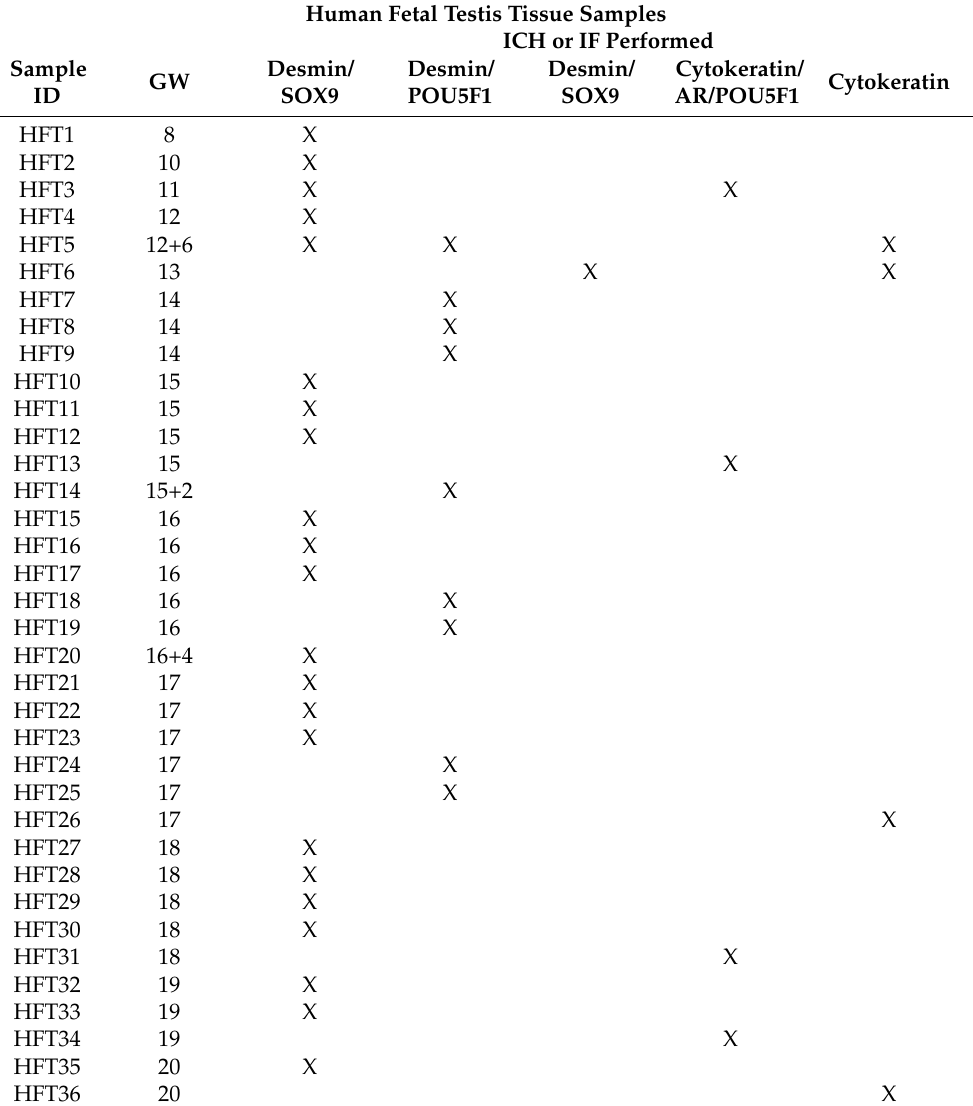
Table A1. Immunohistochemistry and Immunofluorescence performed on human fetal testis samples. Human Fetal Testis Tissue